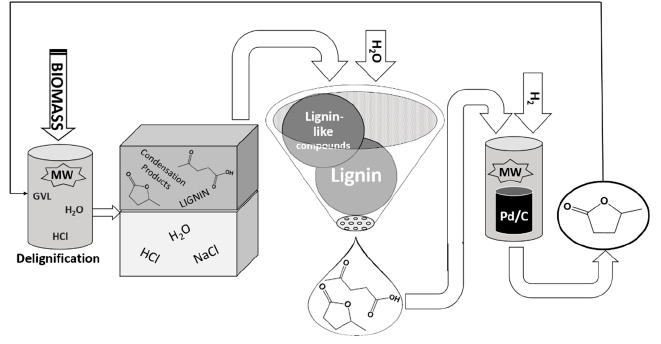
Figure 1. Scheme of the cascade process for the extraction of lignin.